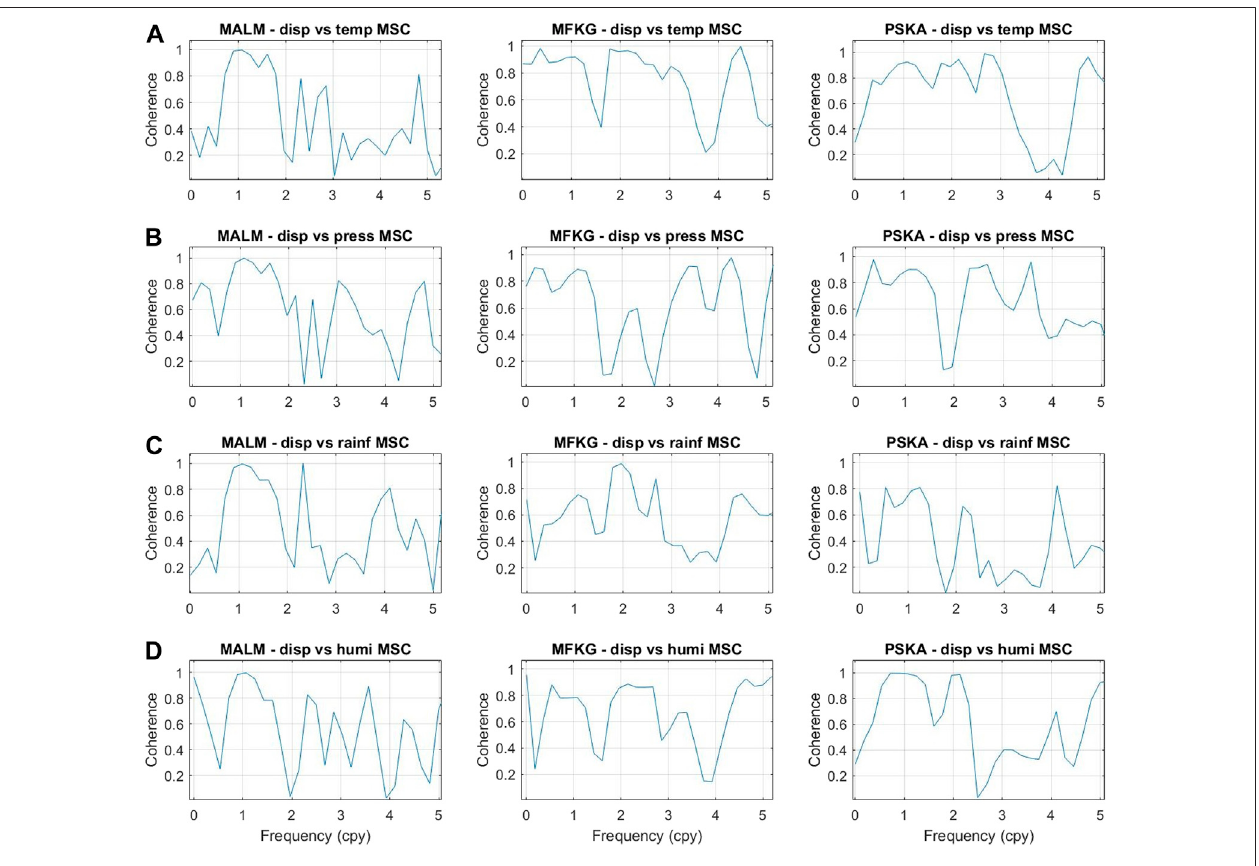
FIGURE 8 | cGPS surface displacement and meteorological time series coherence correlation spectra. (A) displacement-temperature (disp vs. temp), (B) displacement-atmospheric pressure (disp vs. pressure), (C) displacement-rainfall (disp vs. rainf), and (D) displacement-humidity (disp vs. humi). 32.